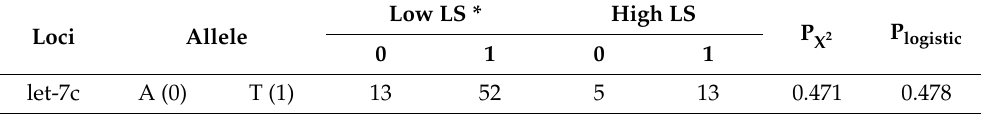
P logistic P X 2